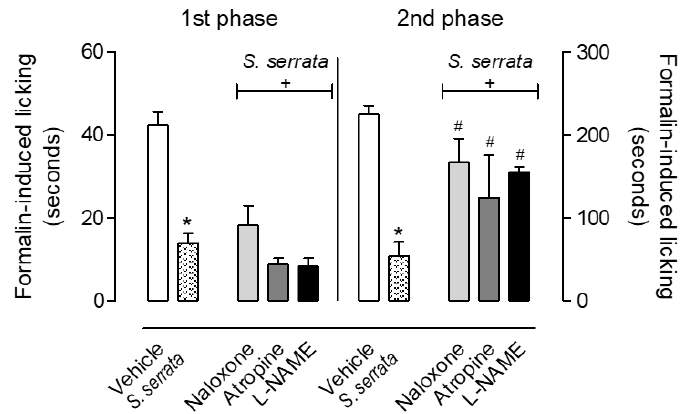
Figure 3. Effects of different antagonists on the antinociceptive activity of the essential oil of Stevia serrata in the formalin-induced licking response. Mice received intraperitoneal injection of naloxone (1 mg/kg), atropine (1 mg/kg) or L-NAME (3 mg/kg) 15 min prior to oral administration with the vehicle or essential oil (100 mg/kg). After 60 min, mice received an intraplantar injection of formalin (20 µL, 2.5%). Results are expressed as mean ± S.D. ( n = 6). Data have been analyzed by ANOVA, followed by